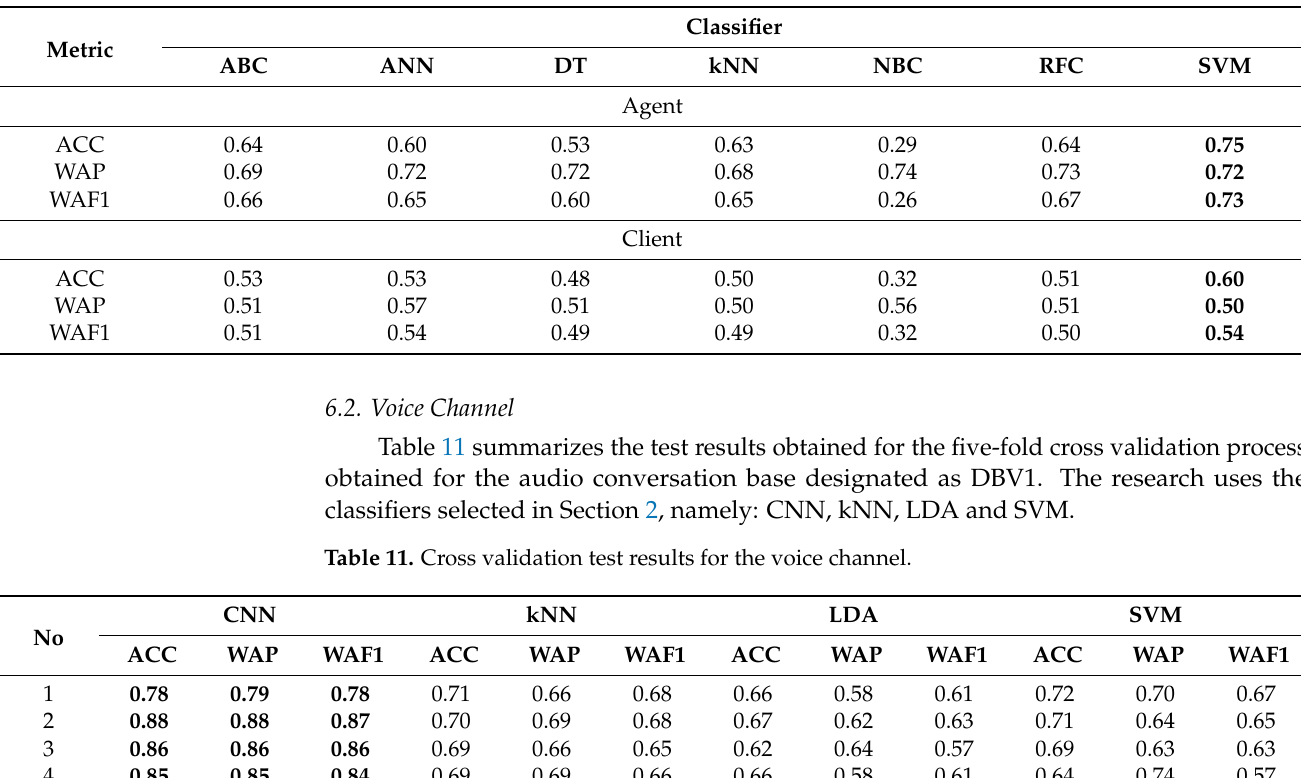
Table 10. Verification of the method based on the DBT2 database.